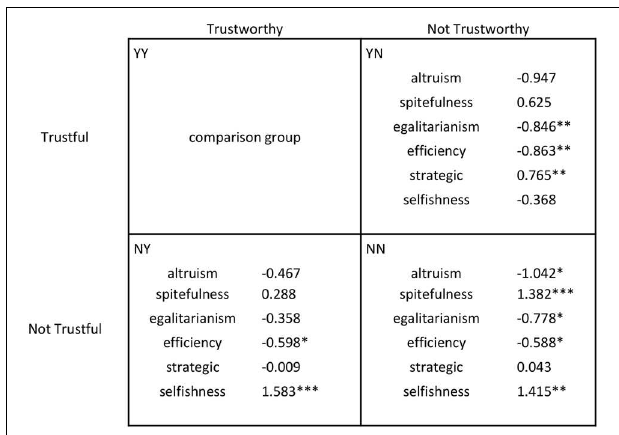
FIGURE 5 | TG outcomes as a function of motive profiles. Multinomial logit output. A positive (negative) coefficient means that individuals with a higher (lower) value of that specific variable (i.e., the motive profile) are more likely to be included in that specific group (i.e., YN, NY, or NN) compared to group YY. Controls are: gender, age, household income, educational level, cognitive skills, risk preferences, and order effects. Complete regressions comparing all groups as well as regressions without controls can be found in Appendix Table A3. ∗ p < 0.10 , ∗∗ p < 0.05 , ∗∗∗ p <